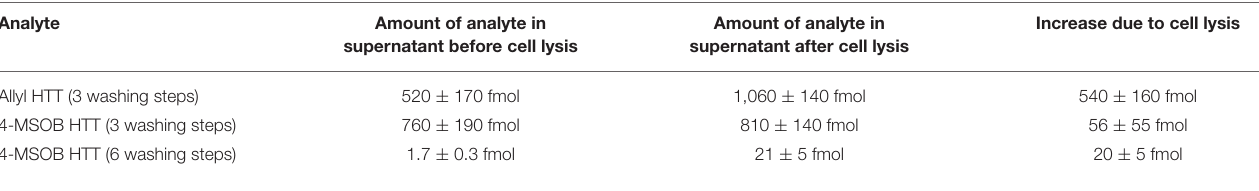
TABLE 2 | Minimum cellular uptake of 3-allyl-4-hydroxythiazolidine-2-thione (allyl HTT) and 4-hydroxy-3-(4-(methylsulfinyl)butyl)thiazolidine-2-thione (4-MSOB HTT) into HepG2 cells as measured by LC-MS/MS as content in the supernatant before and after cell lysis with estimation of volumes of the supernatants before ultrasonic and acetonitrile treatment ( n = 3 biological replicates, data shown as mean ± SD). Analyte Amount of analyte in Amount of analyte in Increase due to cell lysis supernatant before cell lysis supernatant after cell lysis Allyl HTT (3 washing steps) 520 ± 170